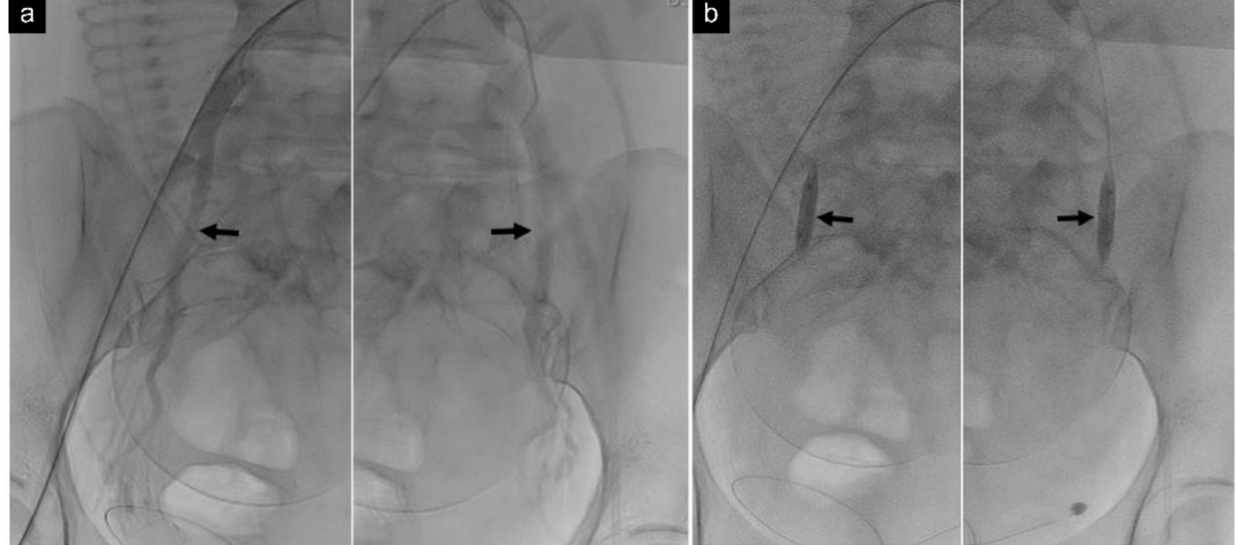
Figure 2. Temporary transcatheter balloon occlusion of bilateral internal iliac arteries. ( a ) Contrast fluoroscopic image of a 40-year-old woman shows the exact level and diameter of bilateral internal iliac arteries (arrows). ( b ) Preoperative fluoroscopic image shows balloon catheters (arrows) in the proximal internal iliac